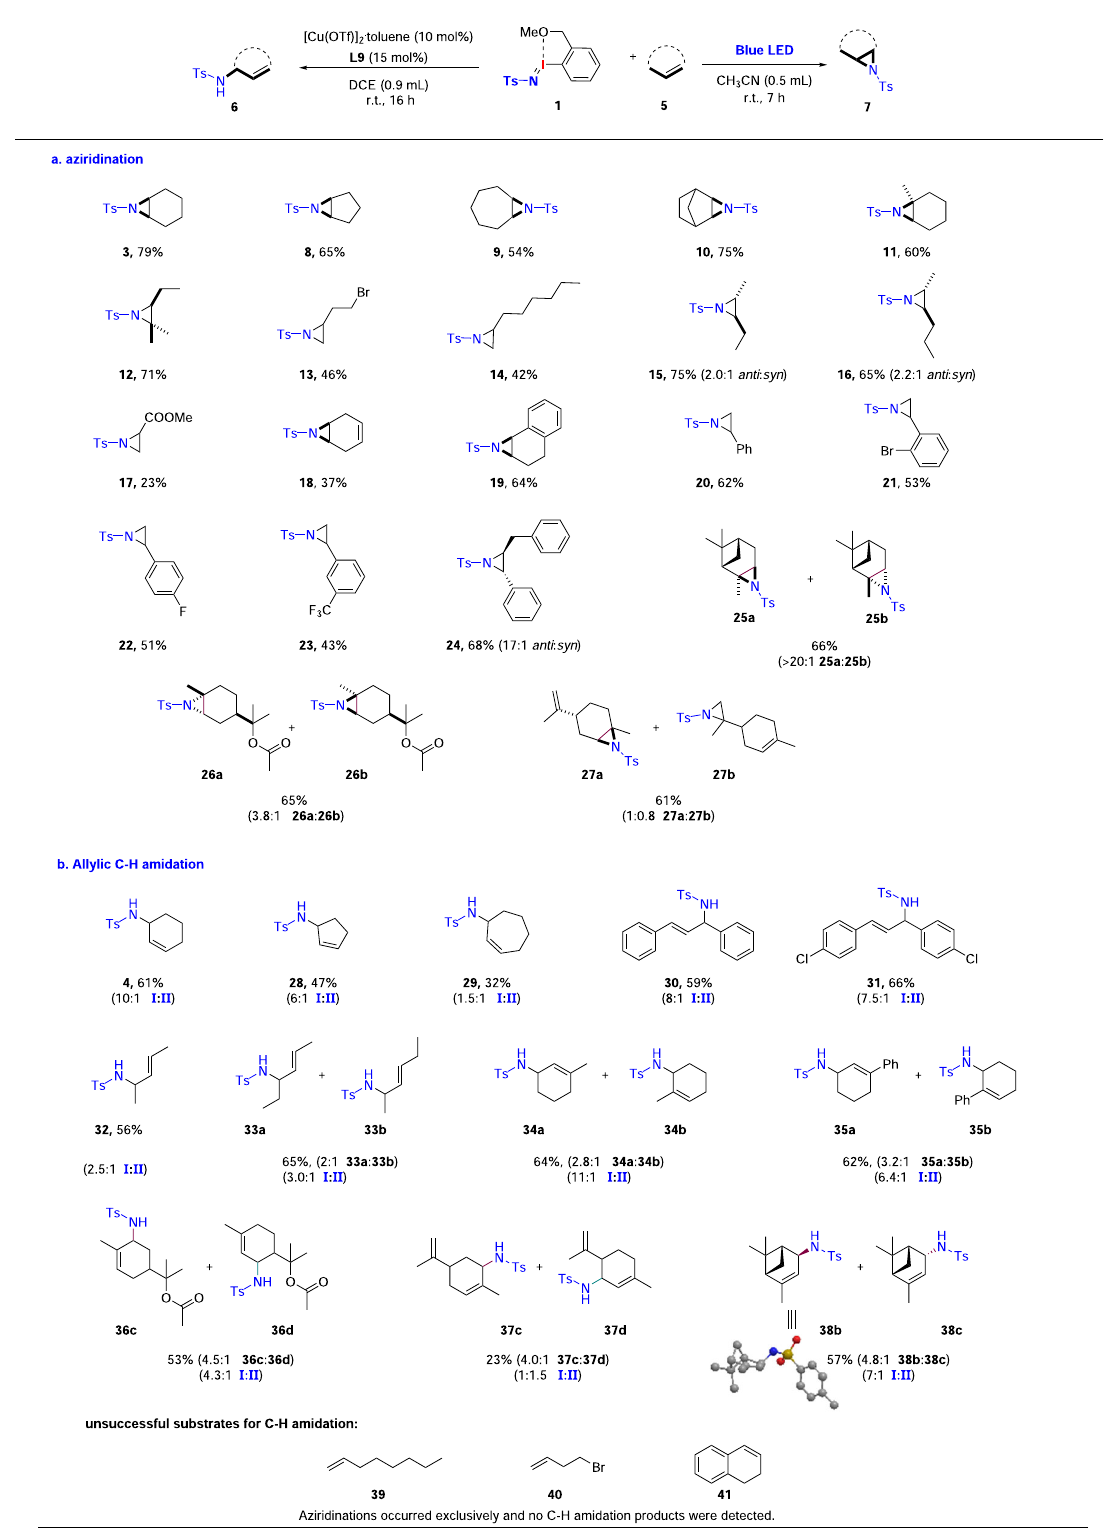
Fig. 2 The reaction scope. a The reaction scope of blue light-induced aziridination of alkenes. Reaction conditions: 1 (0.05 mmol), 5 (0.25 mmol), in CH 3 CN (0.5 mL) under 12 W blue LEDs (435 – 445 nm) at room temperature for 7 h. Isolated yield. b The reaction scope of copper-catalyzed allylic C – H amination. Reaction conditions: 1 (0.1 mmol), 5 (0.5 mmol), [Cu(OTf)] 2 ·toluene (10 mol%), L 9 (15 mol%), 4ÅMS (100 mg), DCE (0.9 mL), r.t., under N 2 for 16 h. Isolated yield. The ratio of isomers determined by 1 H NMR is given in the parenthesis. The ratio of C – H amination/C = C aziridination product ( I : II ) determined by 1 H NMR is given in the